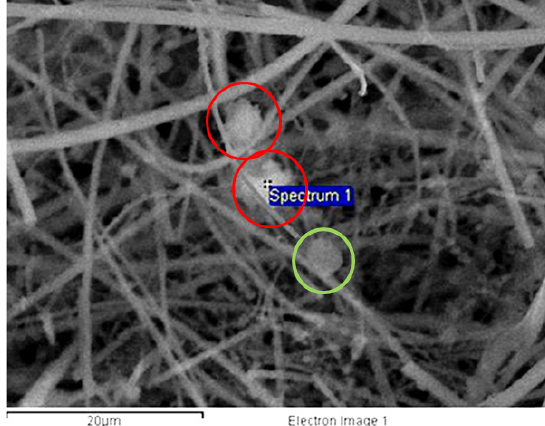
Figure 8. SEM micrograph of the co-existence of both sphere-like (green cycle) and soot-dendritic (red cycle)